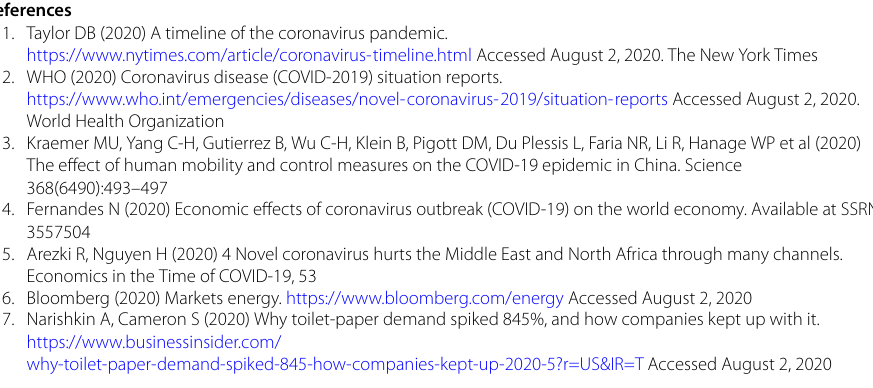
Acknowledgements Not